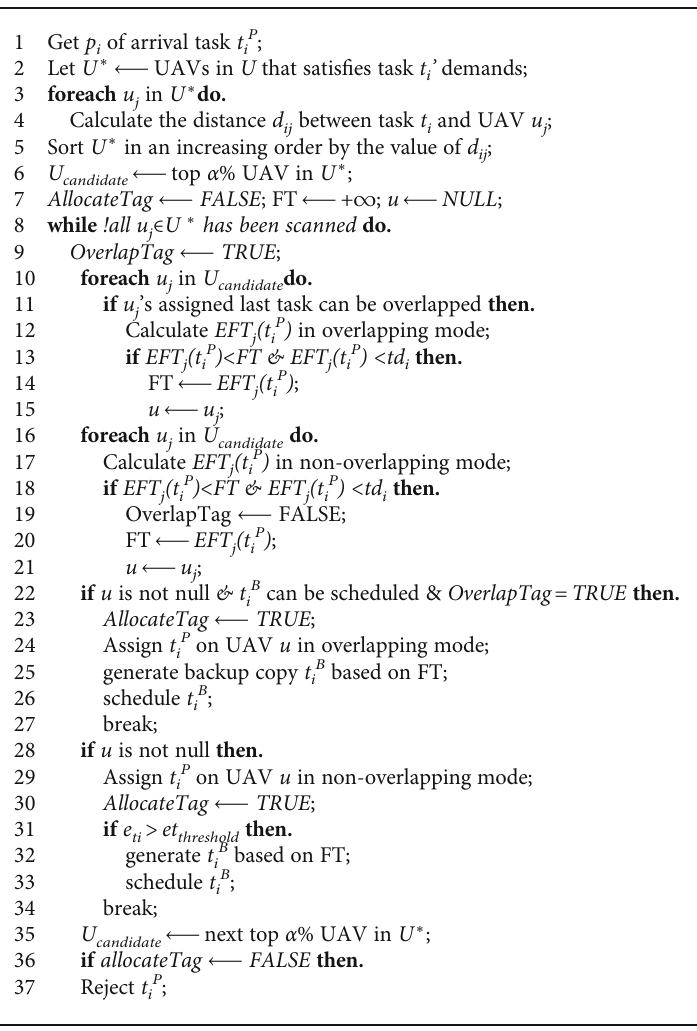
Algorithm 1: Primary Copies Assigning in